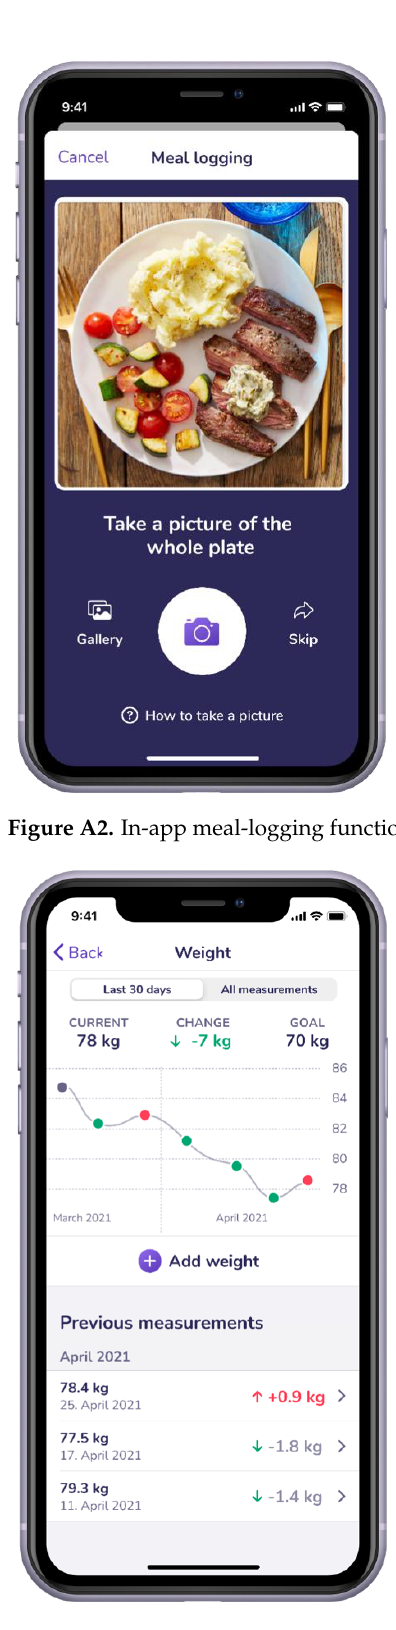
Figure A1. Interactive education in the app.